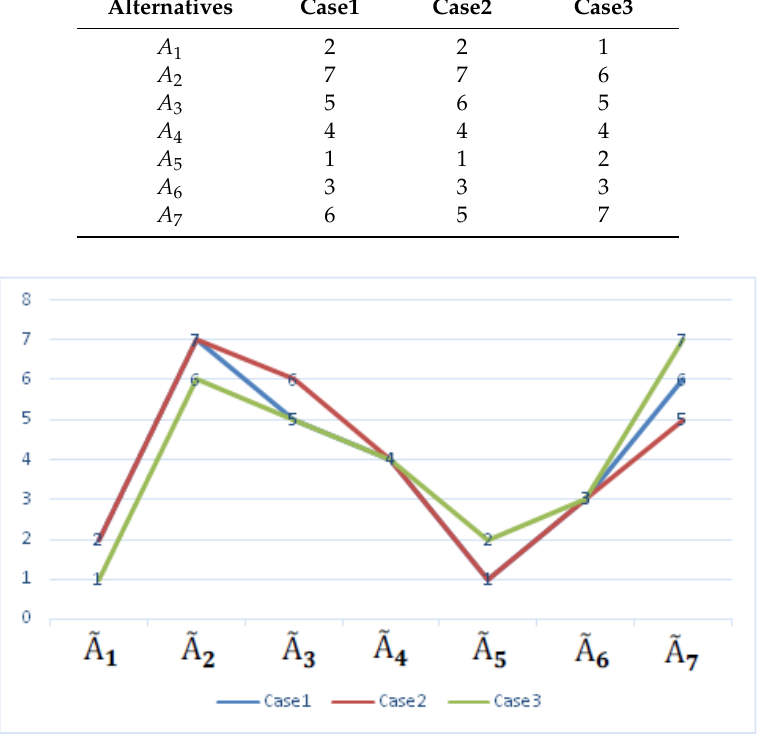
Figure 6. Ranking of alternate sites as per different cases of Sensitivity Analysis from Table 16. Table 16. Different Rankings obtained under different cases.